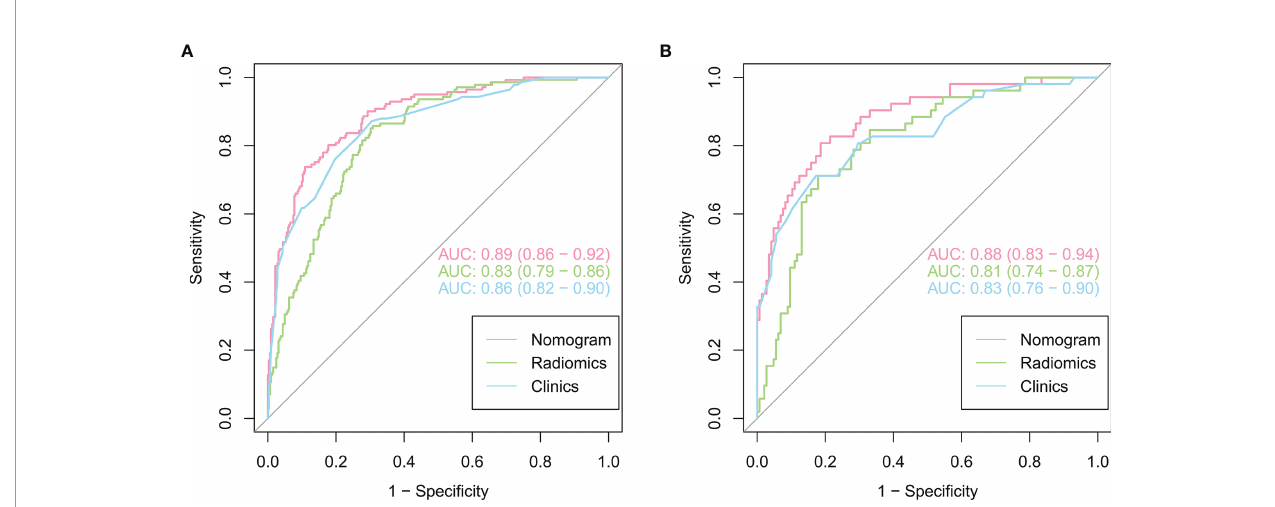
FIGURE 4 | Comparison of the performance of three models for predicting VPI in lung adenocarcinoma. ROC curves for clinical features alone, radiomics features alone and combined features for the training (A) and validation (B)